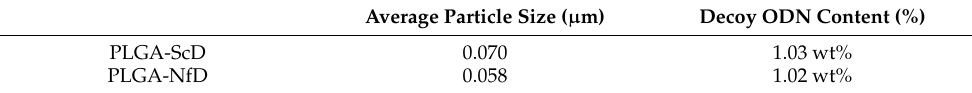
Table 1. Physicochemical properties of the decoy ODN-loaded PLGA nanospheres.